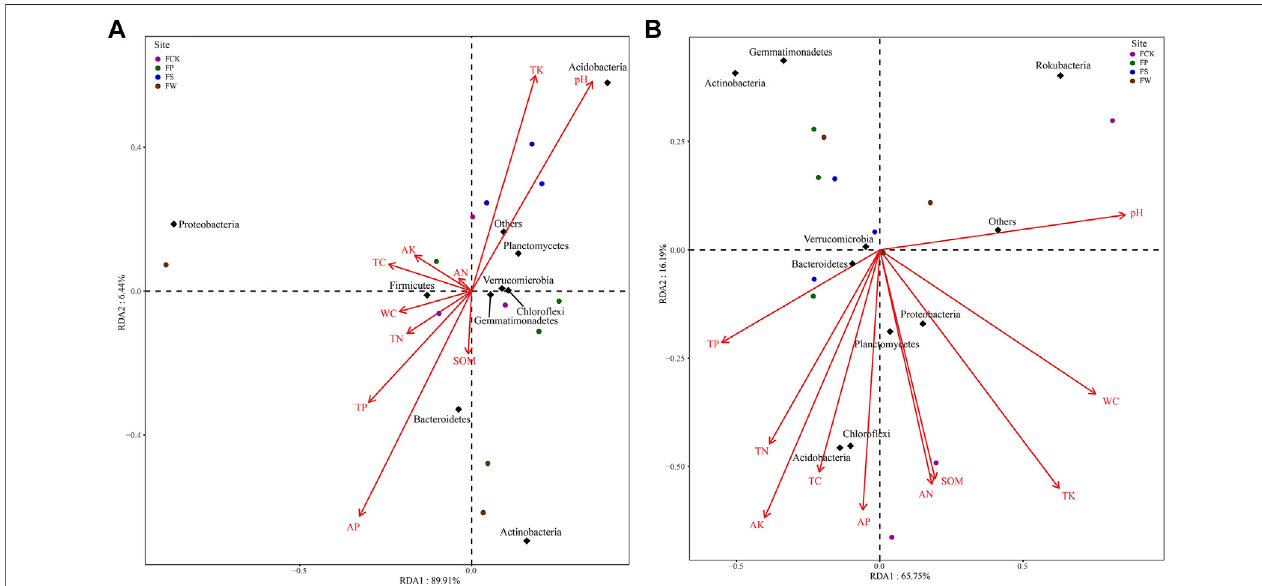
TABLE 3 | Pearson ’ s correlation between alpha diversity indices of bacterial community and soil physicochemical properties. Parameters pH